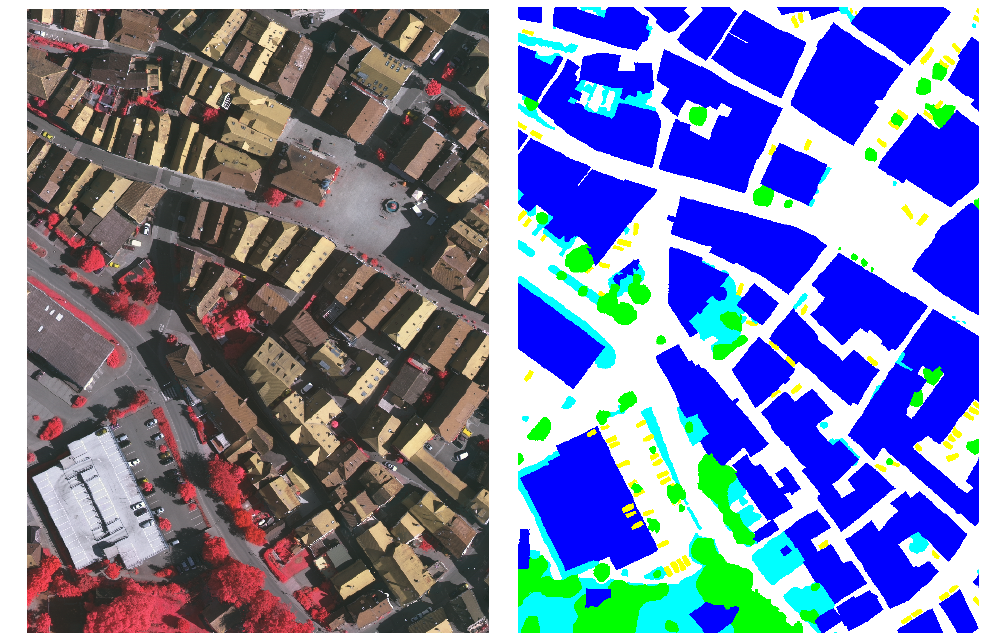
Figure 9. Sample of input scene from Figure 8 (left) and target image (right). The annotated Vaihingen corpus has five categories: tree (green), building (blue), clutter/background (red), low vegetation or LV (greenish-blue), and impervious surface or imp surf